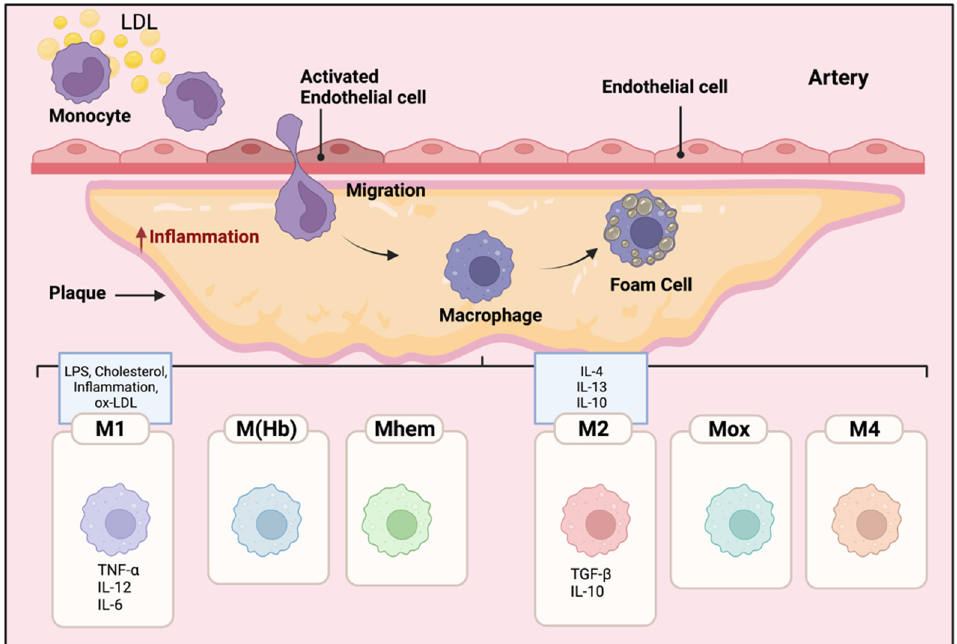
Figure 2. Mac polarization in atherosclerotic plaques. The microenvironment of the lesion affects the differentiation of monocytes to Macs. The Macs transform into foam cells and are retained in the plaques. Therefore, pro and anti-inflammatory Macs exacerbate or alleviate the disease, respectively. The polarization of Macs changes their functional phenotype in response to the signals in their microenvironment. Different subclasses of Macs have been identified in the plaques including M1, M(Hb), Mhem, M2, Mox, and M4. M1 Macs in atherosclerotic lesions can be stimulated by cholesterol crystals, LPS, pro-inflammatory cytokines, and oxidized LDL. They secrete pro-inflammatory cytokines such as TNF- α , IL-6, IL-12; in contrast, activated M2 Macs produce anti-inflammatory cytokines such as IL-10 and IL-4.